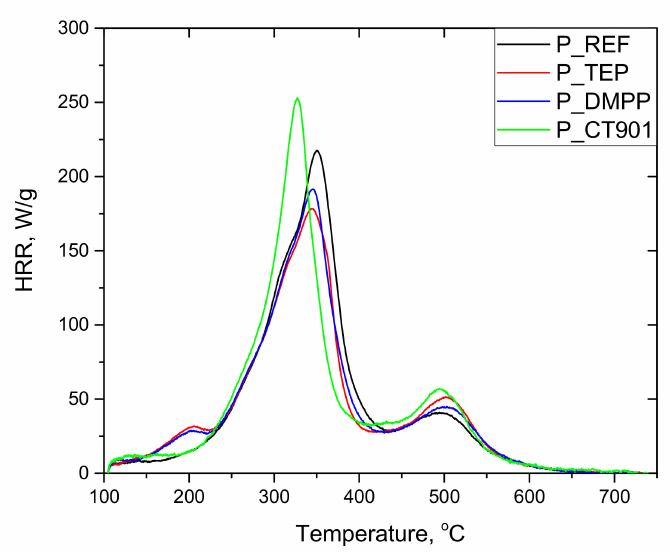
Figure 9. HRR curves of rigid polyurethane foams without the addition of bio-polyol. Each material modified with the flame retardant had a lower THR value compared to the foams without flame retardants. In the case of foams obtained exclusively from petrochemical polyol, the most significant reduction in THR was caused by the addition of DMPP, and for the foams containing the bio-polyol and Addforce CT